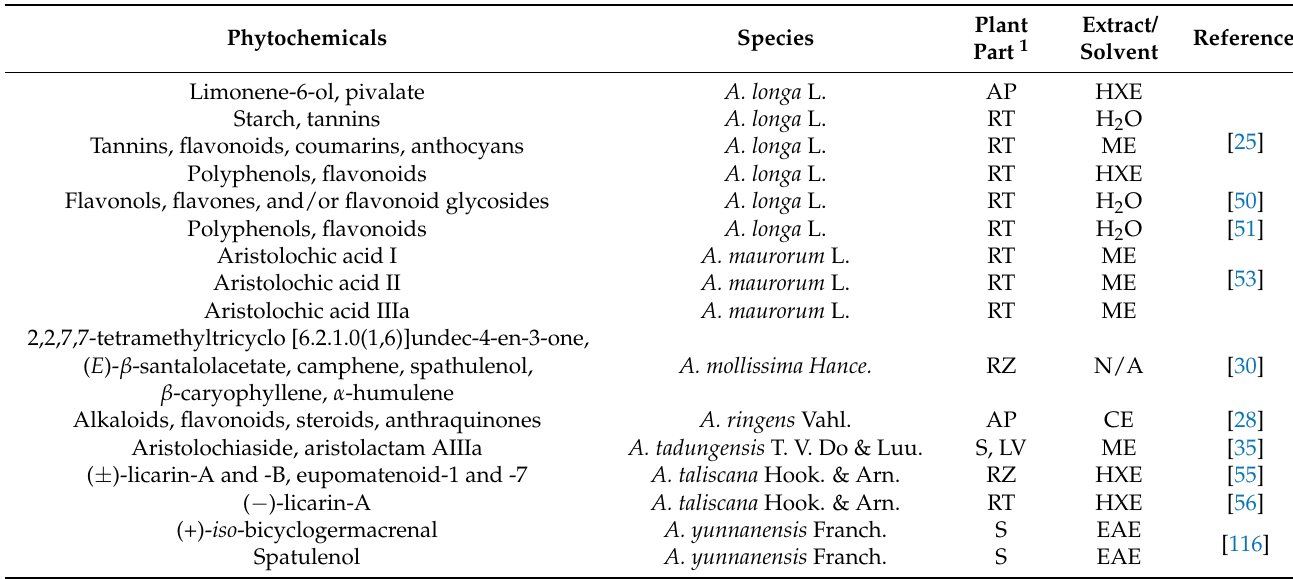
Table 1. Cont. Phytochemicals